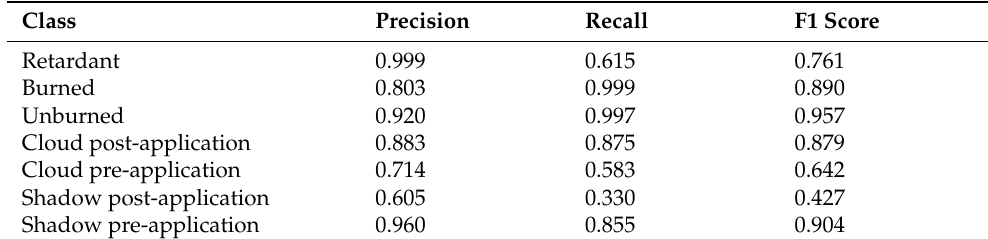
Table 3. Individual class accuracy metrics of the best model (GB, Multiclass, Difference) on the test data